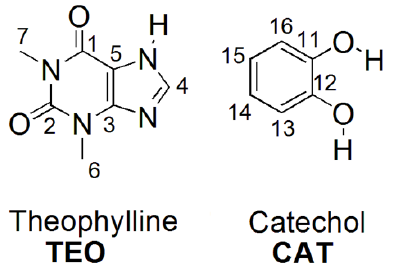
Figure 1. Chemical structure and numbering of CAT and TEO.